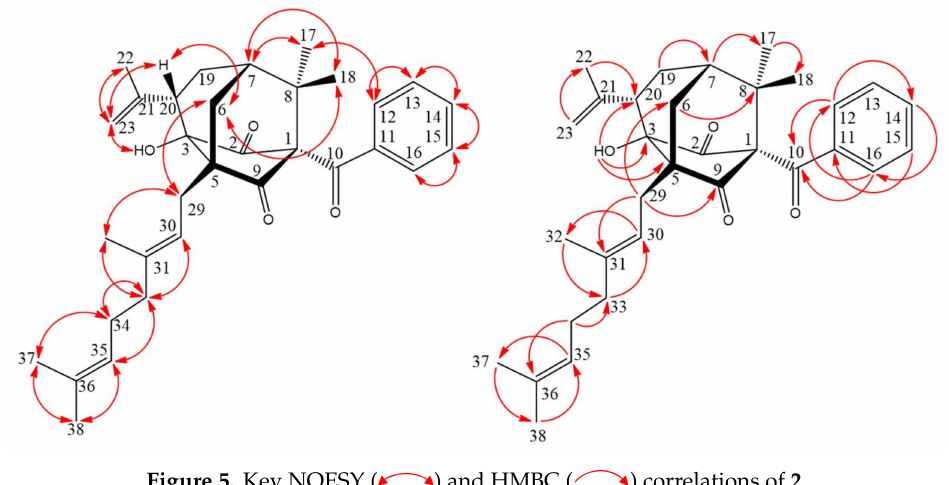
Figure 5. Key NOESY ( ) and HMBC ( ) correlations of 2